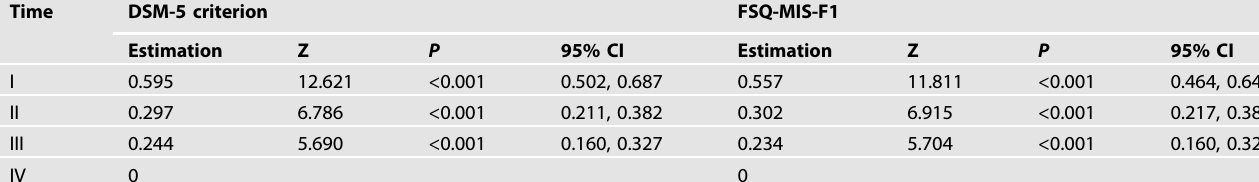
Table 4. Parameter estimation of General Loglinear Analysis.